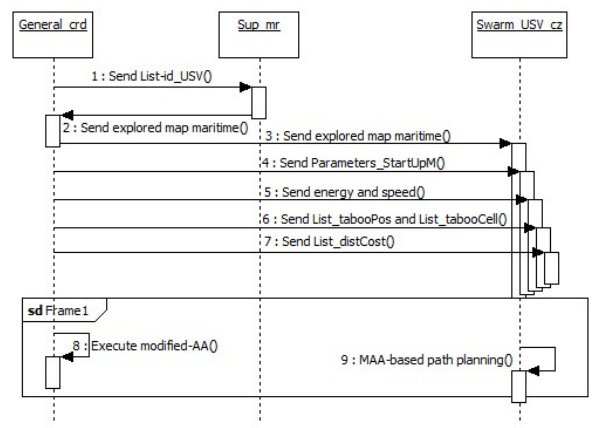
Figure 9: Sequence diagram of the ‘modified-AA based trigger pro- cess for USV cz